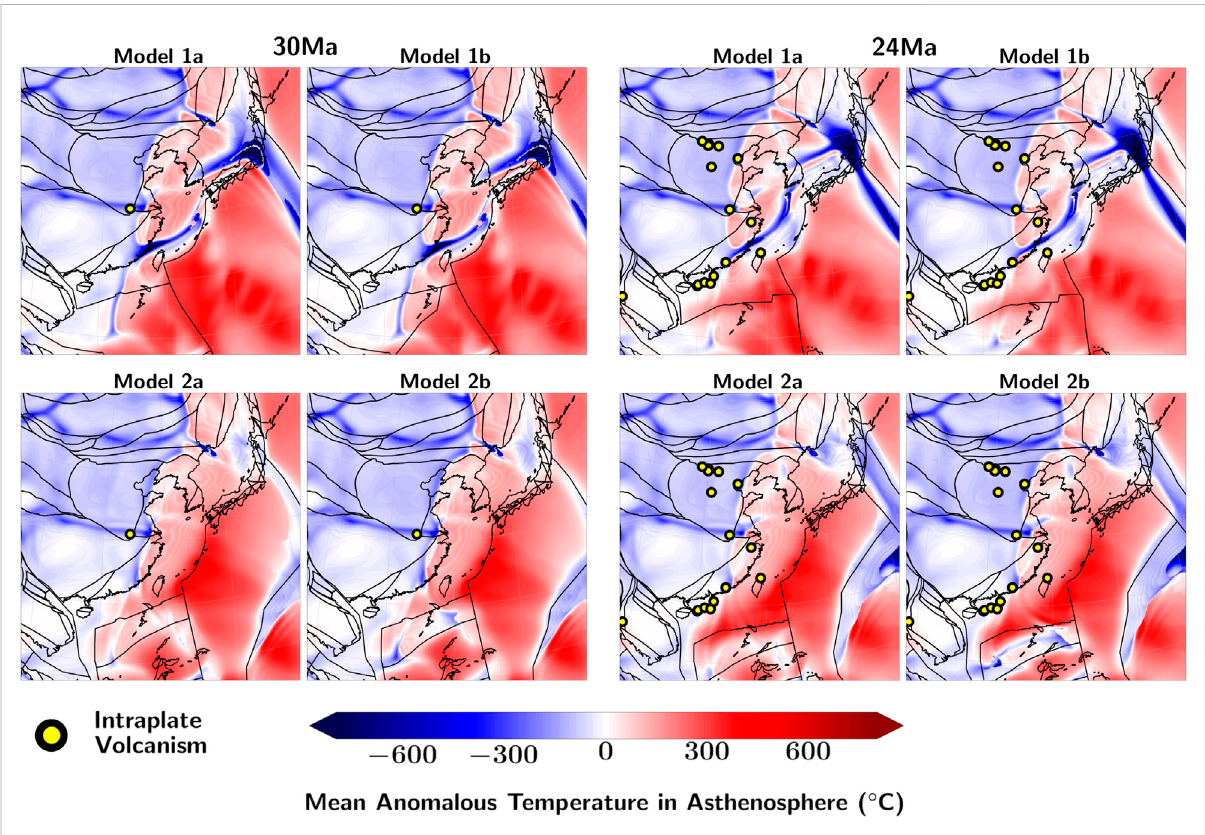
FIGURE 5 Maps of mean anomalous asthenospheric temperature predicted by the models of Lin et al. (2020) at six times from 30 to 0 Ma, with superimposed distribution of coeval intraplate volcanism (Arai et al., 2001; Sun et al., 2010; Gong and Chen, 2014; Ball et al., 2021). Note the connection between the distribution of anomalously hot material underneath the Eurasian plate and the location of intraplate volcanic eruptions, with the notable exceptions of the Hannuoba and Taihang basalts at 24 – 18 Ma and the eruptions in the Indochina